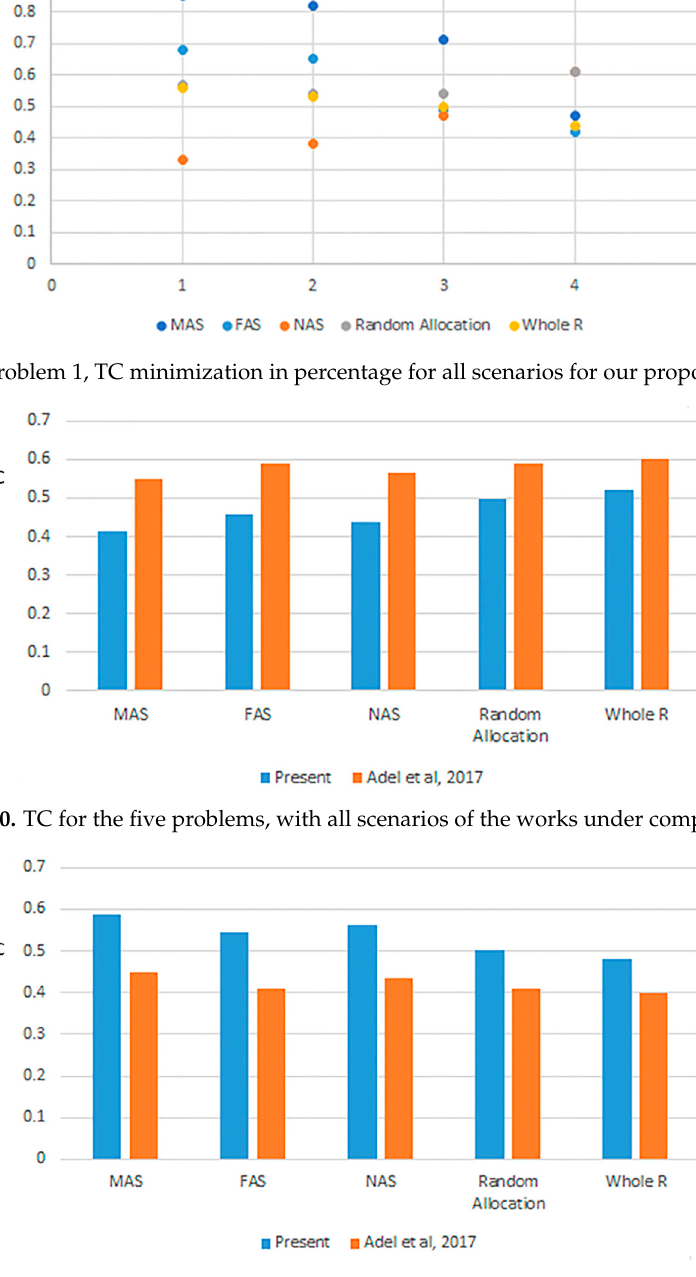
Figure 11. Performance for the five problems, with all scenarios of the works under comparison.